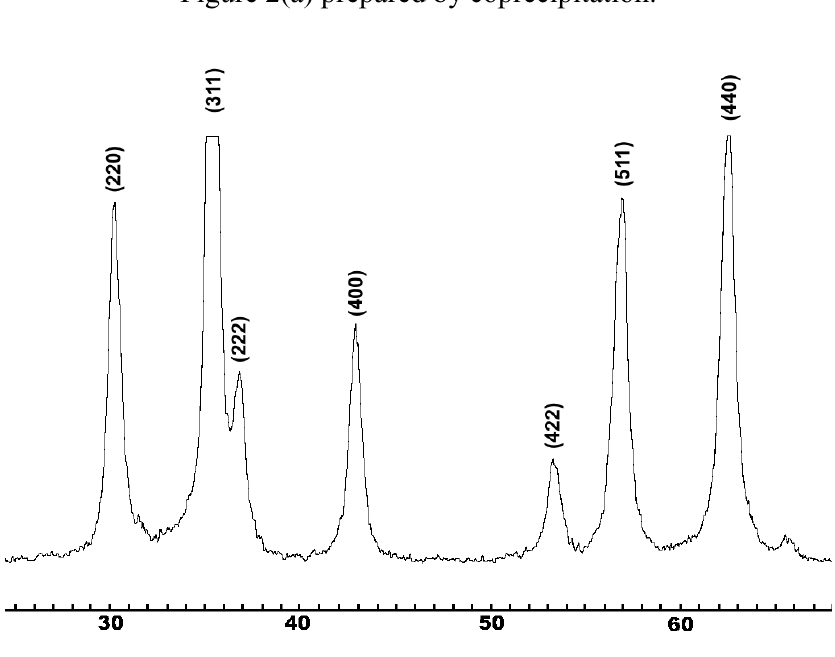
Figure 2(b) prepared by spraying coprecipitation. Figure 2. XRD pattern of ZnGa